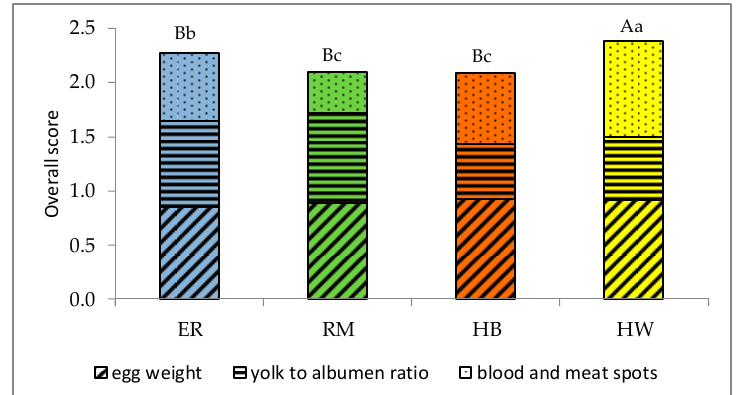
Figure 8. E ff ect of genotype 1 on the overall score of the eggs based on egg weight, yolk to albumen ratio and blood and meat spots. Di ff erent letters among columns indicate di ff erent values. a, b, c: p < 0.05; A, B, C: p < 0.01. 1 Genotype: ER—Ermellinata di Rovigo; RM—Robusta maculata; HB —Hy Line Brown; HW—Hy Line White 36. Observations ( n ) per each genotype: 112. χ 2 p -value: 0.0002.